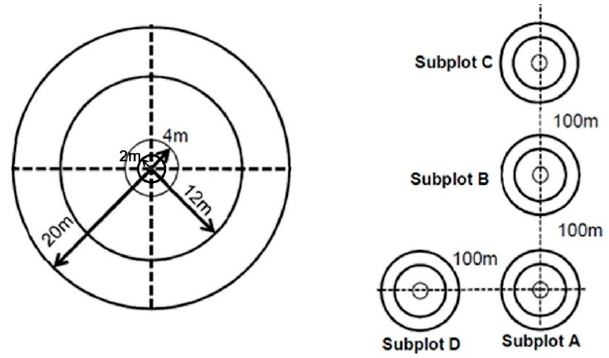
Figure 3. Layout of the sampling plot and sampling design of a cluster of sample.